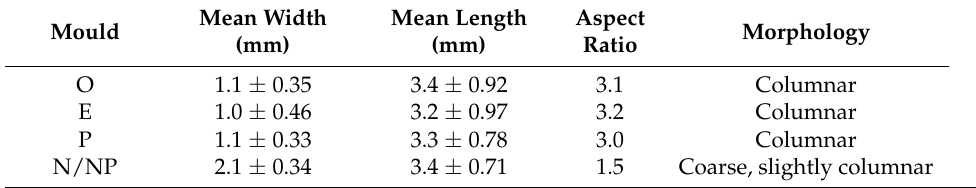
Table 4. Grain size (mean with and length with standard deviation) in the as-cast